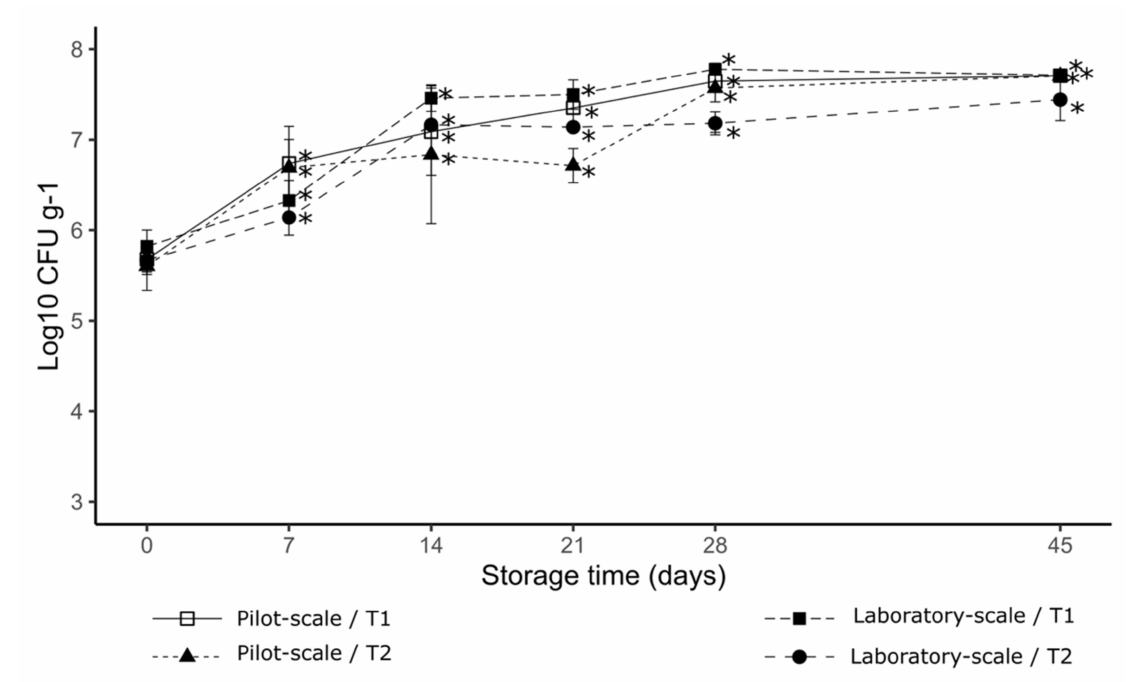
Figure 3. The effect of the emulsifying salts on C. perfringens ATCC 13124 development, with different processing methods over storage time. (*) indicates a significant difference with the zero time of storage, according to Tukey’s test ( p < 0.05). Error bars show standard deviations of the mean.